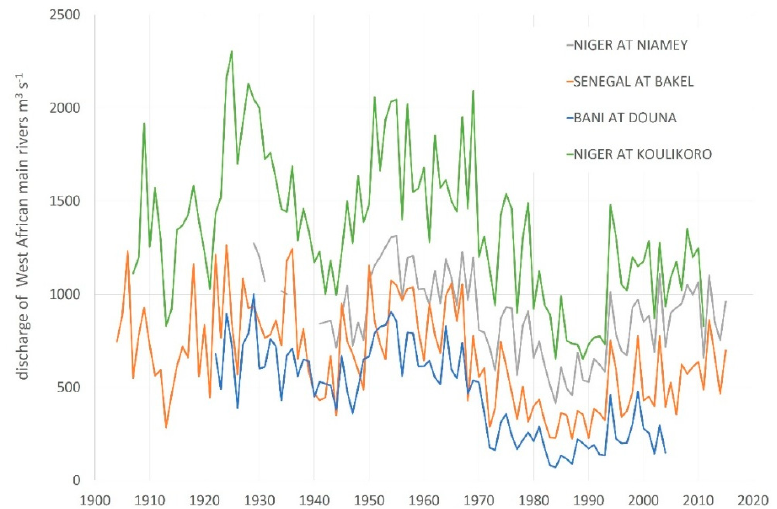
Figure 6. Discharge evolution of four basins: this comprises all the data available for rivers before the wet 1950–1967 period.